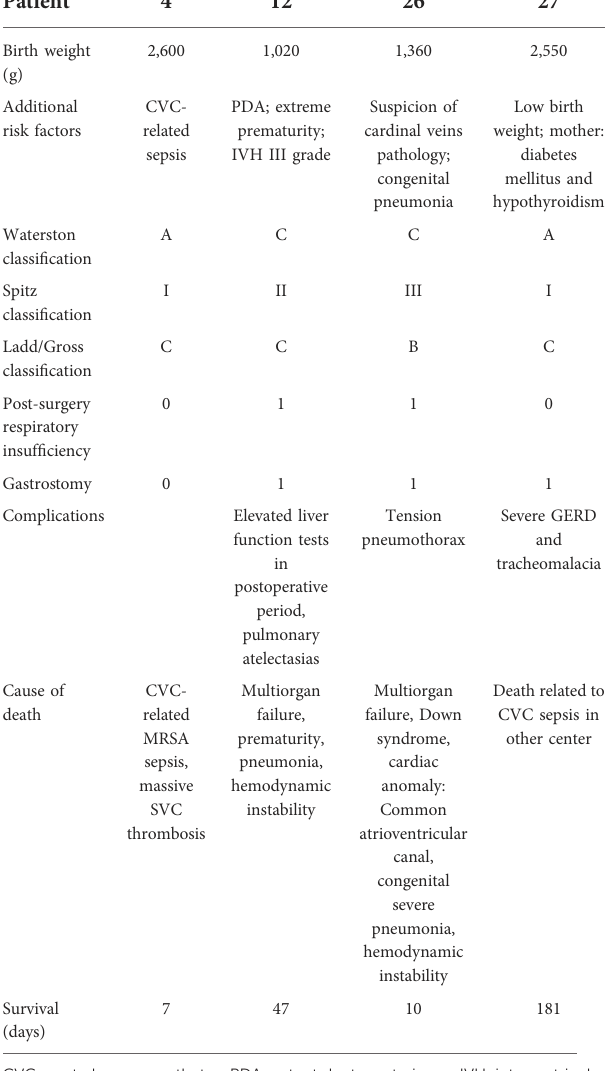
TABLE 8 Causes of deaths.